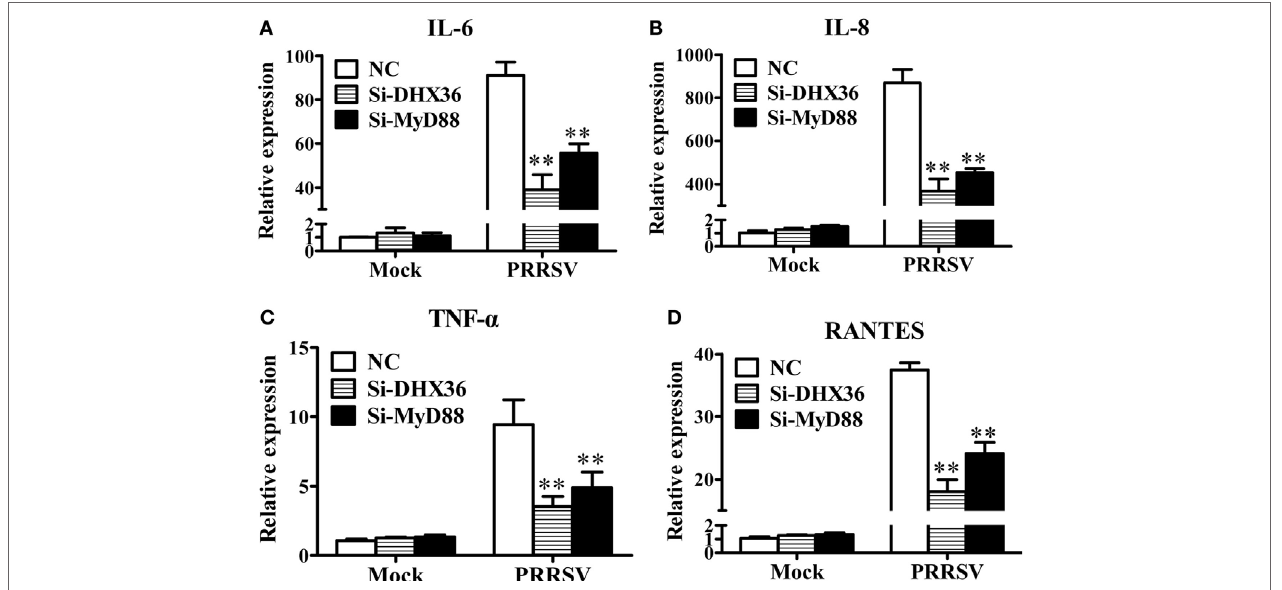
FigUre 5 | The DExD/H-box helicase 36 (DHX36)–MyD88 axis is involved in porcine reproductive and respiratory syndrome virus (PRRSV)-induced production of pro-inflammatory cytokines. (a–D) MARC-145 cells were transfected with si-DHX36, si-MyD88 or negative control small interfering RNA for 24 h prior to PRRSV (MOI = 1) infection for 36 h. The mRNA expression of IL-6 (a) , IL-8 (B) , TNF- α (c) , and RANTES (D) was evaluated by real-time RT-PCR.